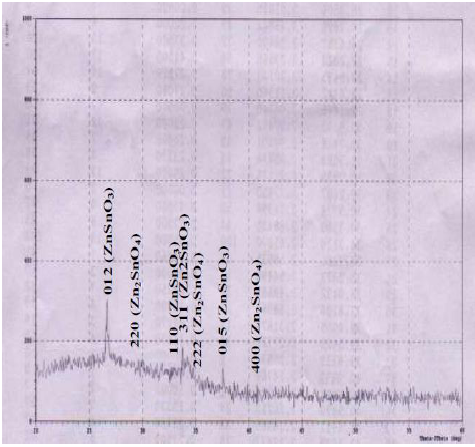
Fig. 5: XRD Spectra of Z